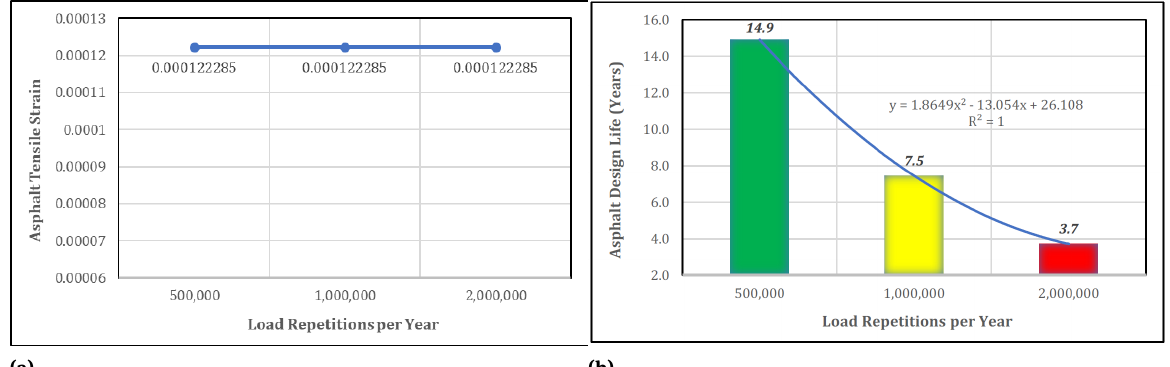
Figure 17: Influence of load repetitions on asphalt service life in asphaltic overlayment rail